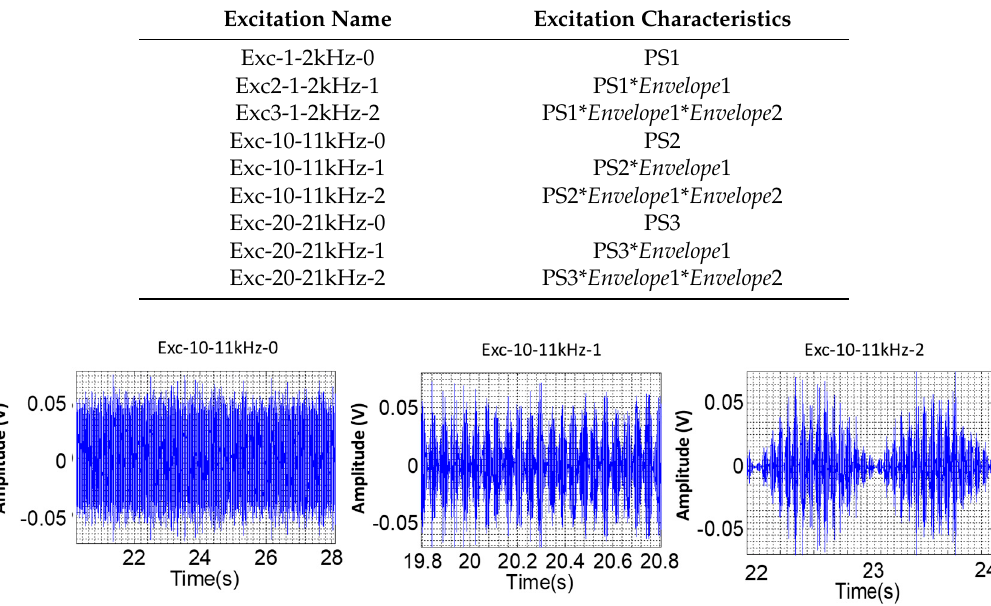
Figure 3. Example of the different excitations used.